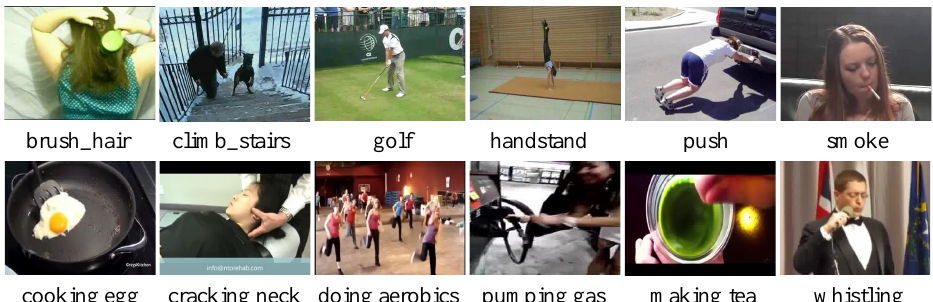
Figure 4. Examples of the dataset visualization. The top line is the examples of HMDB-51 dataset, and the bottom line is the examples of Kinetics